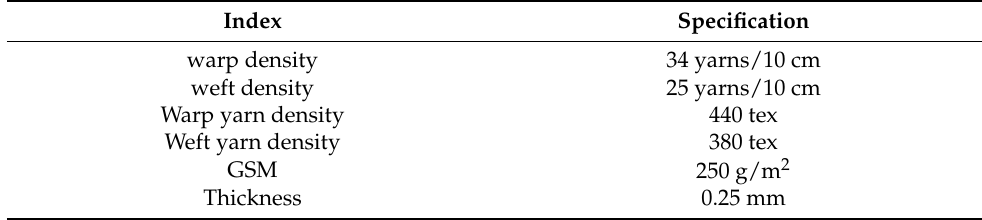
Table 1. Glass fibre fabric specifications.